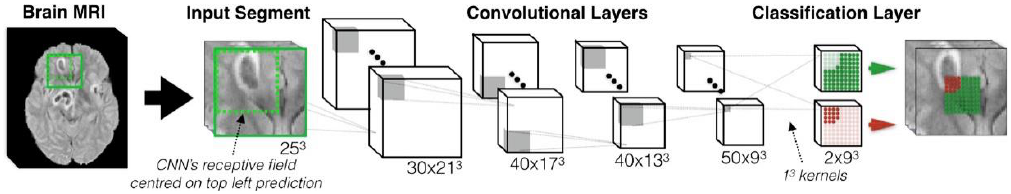
Figure 6. The baseline architecture of 3D convolution neural network (CNN) for lesion segmentation. The figure is slightly modified from [54].